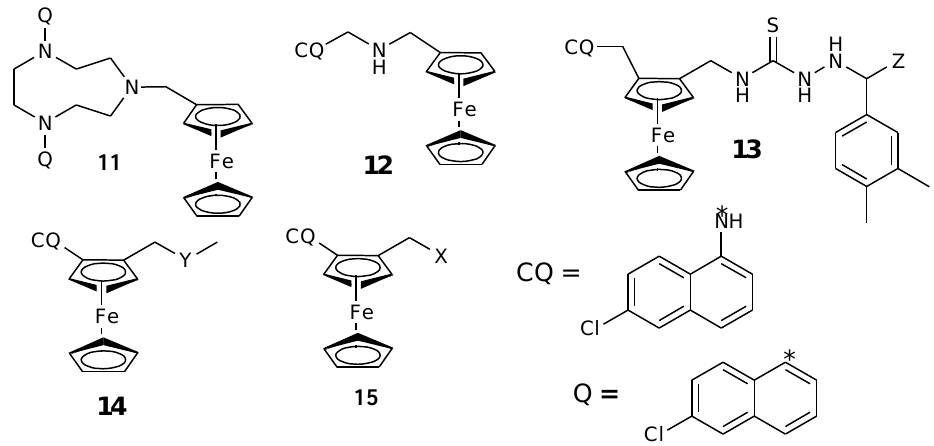
Figure 5. Chemical structures of quinolone-ferrocene hybrids ( 11 – 15 ). 13 -Z = CH 3 , 14-Y = 1,2,3,5-diisopropylidene glucofuranose moiety, 15a -X = diisopropylidene-protected 6-amino-deoxyglucofuranose, 15b -X = 6-amino-6-deoxygalactopyranose.